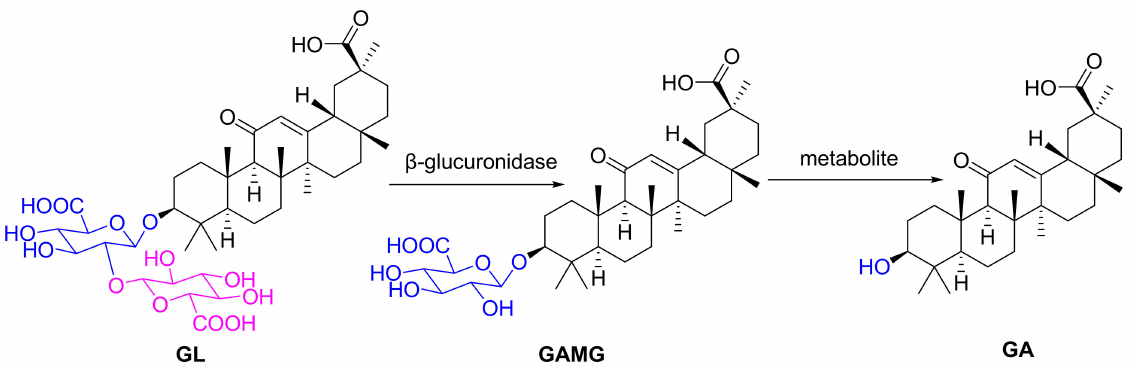
Figure 1. The chemical structural formulas of GL, GAMG and